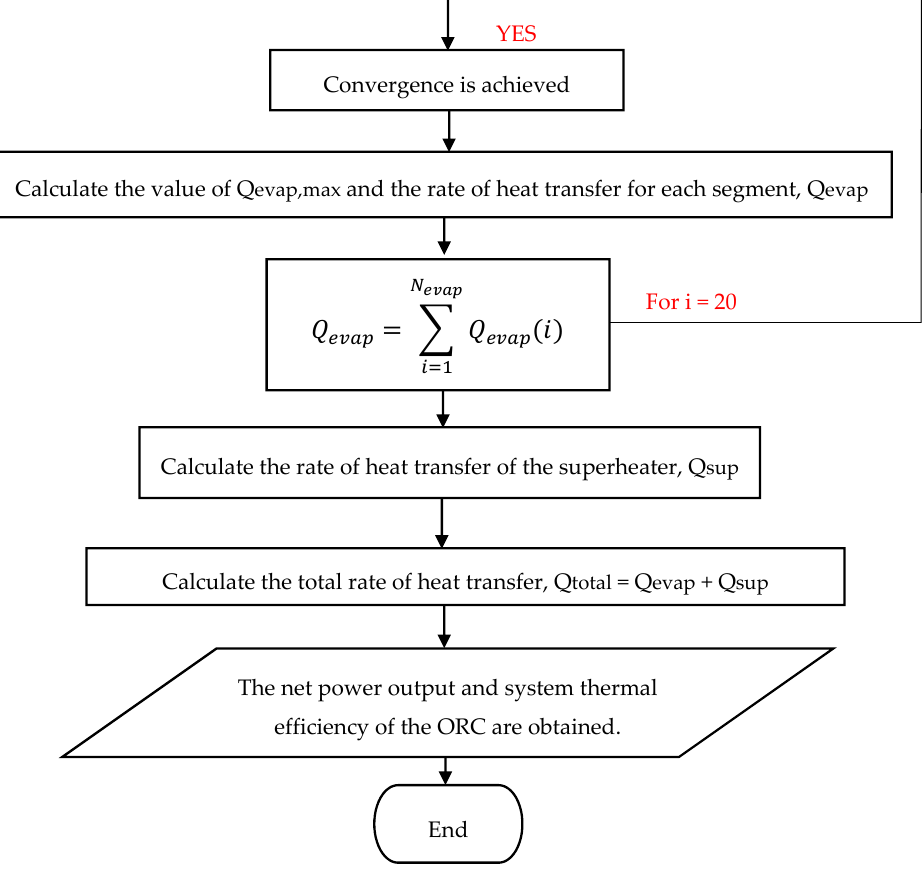
Figure 3. Procedure of performance modeling of ORC system